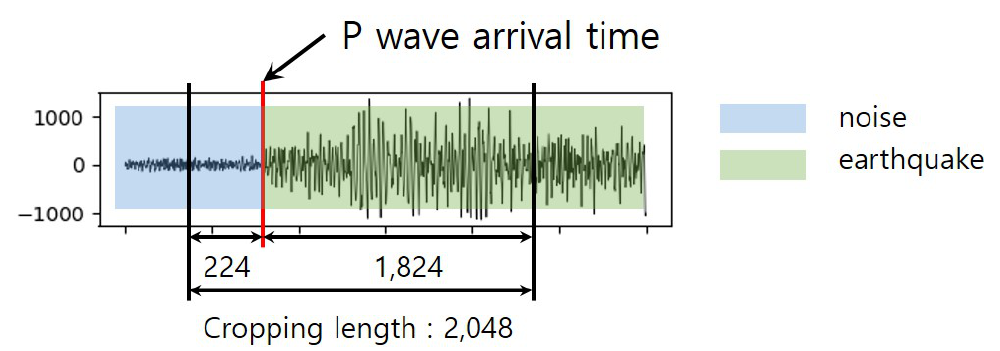
Figure 6. Schematic diagram of seismic signal cropping with 2048 window size.